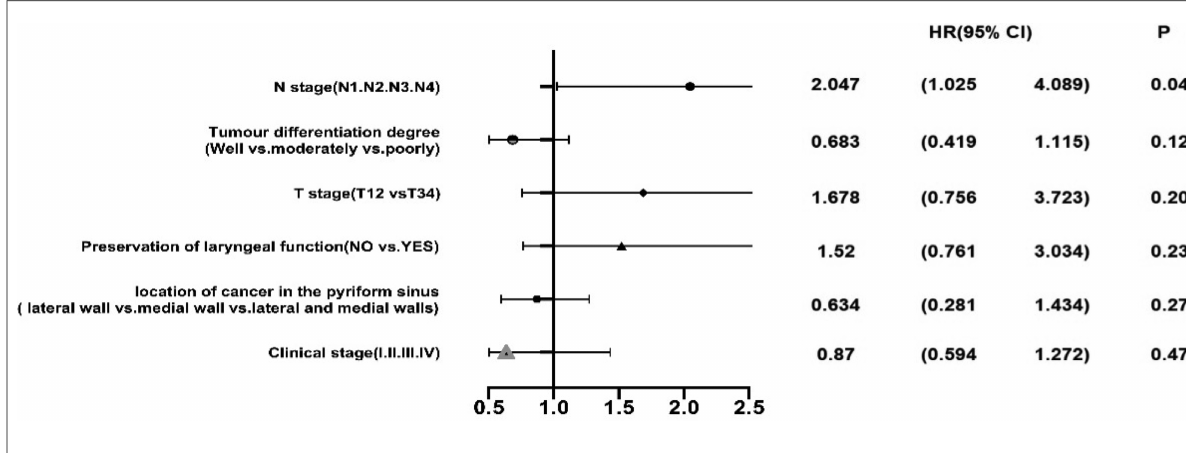
FIGURE 3 Multivariate regression analysis of factors in fl uencing overall